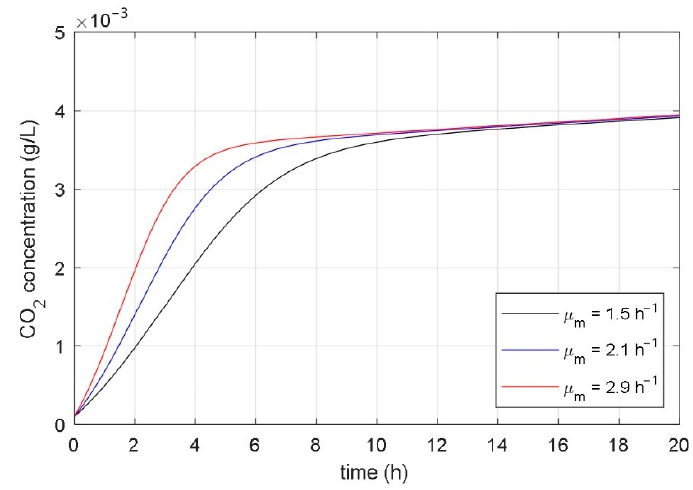
Figure 4. The impact of the maximum microorganisms’ growth rate μ m on the time course of the CO 2 concentration.